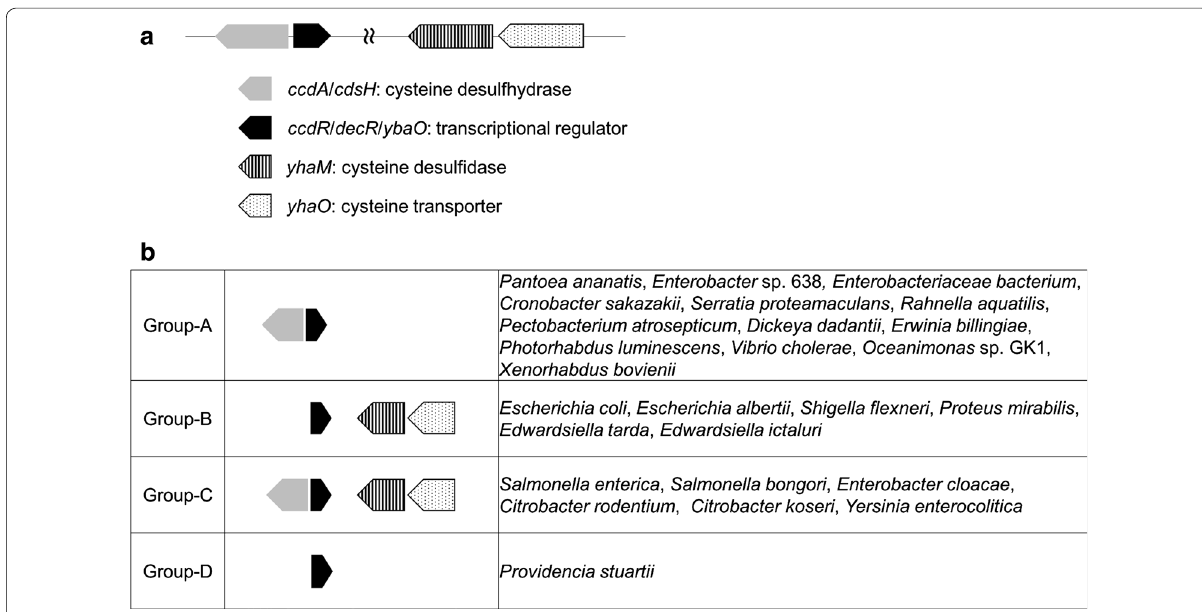
Fig. 4 Conservation and variation of cysteine degradation systems in Enterobacteriaceae bacteria. a Genomic context of the genes in the bacterial cysteine degradation systems conserved in bacteria. b Comparison of the genomic contexts of the bacterial cysteine degradation systems among genomes of Enterobacteriaceae bacteria. Representative examples of bacterial genomes are shown. Note that Xenorhabdus bovienii contains yhaO , and some Escherichia coli strains (e.g., CFT073) and Salmonella enterica strains (e.g., CT18) lack yhaO ; thus, they represent subgroups. Data were obtained using the web resource STRING